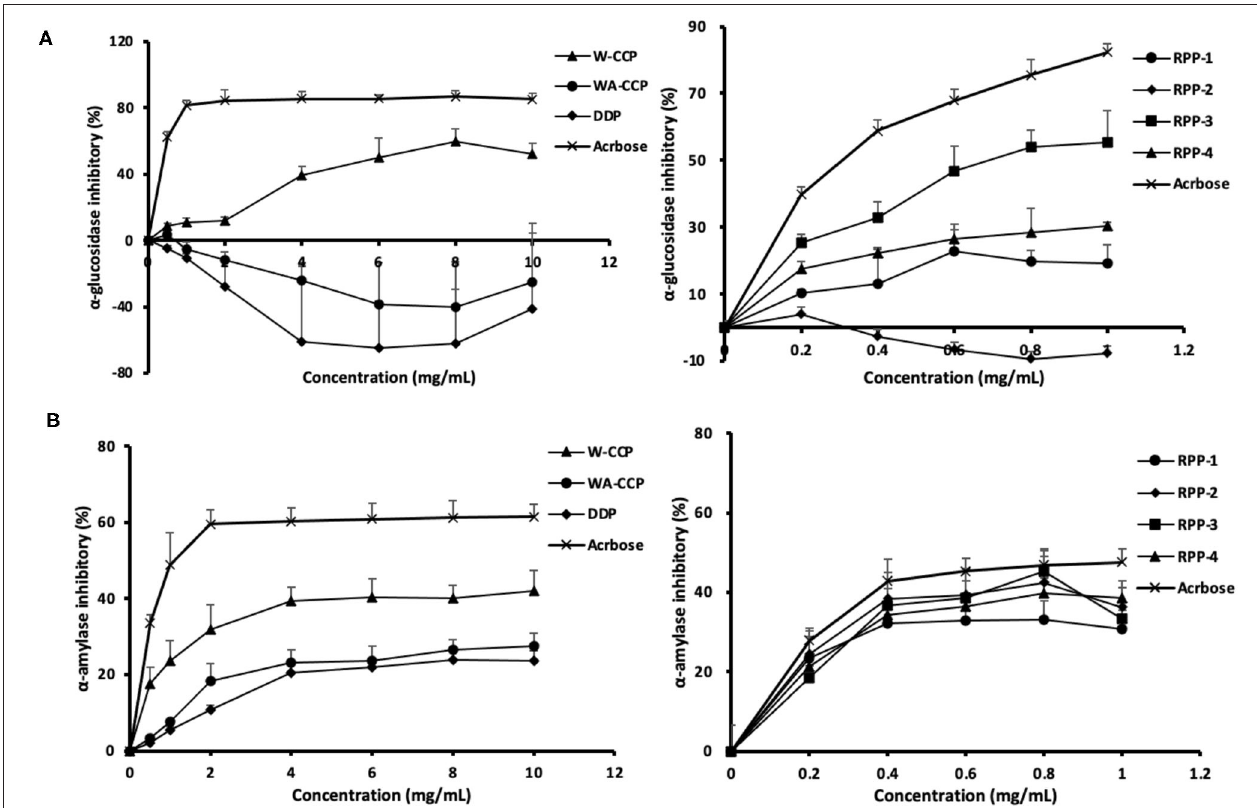
FIGURE 5 | In vitro hypoglycemic effects of the four pumpkin polysaccharides: W-CCPs, WA-CCPs, DPPs, and RPPs. (A) α -Glucosidase inhibitory activities; (B) α -amylase inhibitory activities. Each value was represented as mean ± SD of three independent experiments. W-CPPs, water-extracted crude pumpkin polysaccharides; WA-CPPs, crude pumpkin polysaccharides extracted by water and alcohol; DPPs, deproteinized pumpkin polysaccharides; RPPs, refined pumpkin polysaccharides. Acarbose is the positive control.